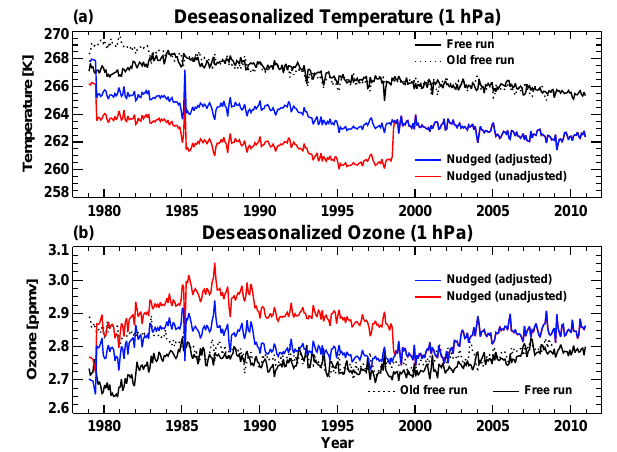
Fig. 5. Global and monthly mean deseasonalized (a) temperature and (b) ozone volume mixing ratio at 1hPa for the adjusted (blue) and unadjusted (red) nudged runs. The free run (i.e. unnudged) is shown in black solid; the old free run in black dotted; see text for details. After August 1998 the red curve underlies the blue since no adjustment is applied